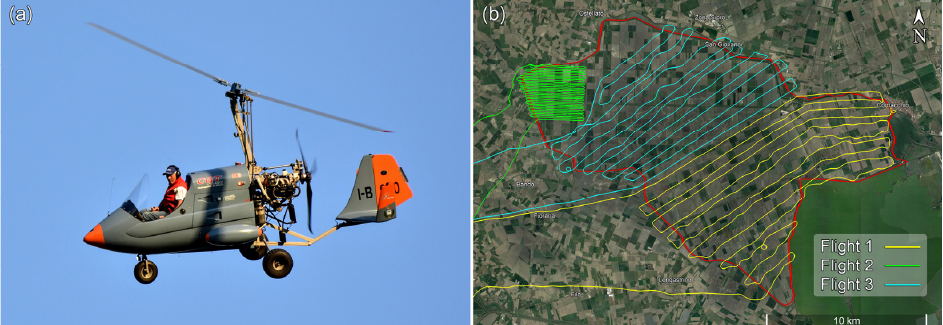
Figure 2. ( a ) The Radgyro, the aircraft used for the AGRS surveys and ( b ) paths of Flights 1, 2 and 3, ranging 184 km, 126 km and 172 km in the Mezzano Lowland, respectively. The distance of the flight lines is ~600 m for Flights 1 and 3; the smaller line spacing of Flight 2 (~100 m) arises from the spatial resolution requirements of the photogrammetric survey simultaneously performed.